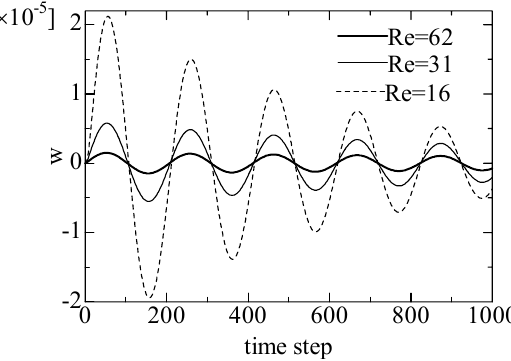
Fig. 9 Time evolution of density at x = ( π , π ,7/8 π